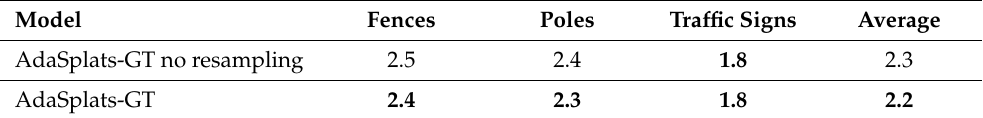
Table 4. Cloud-to-Cloud distance (in cm) computed on PC3D-Paris for points that belong to classes of thin structures between the simulated using AdaSplats without resampling and the original point